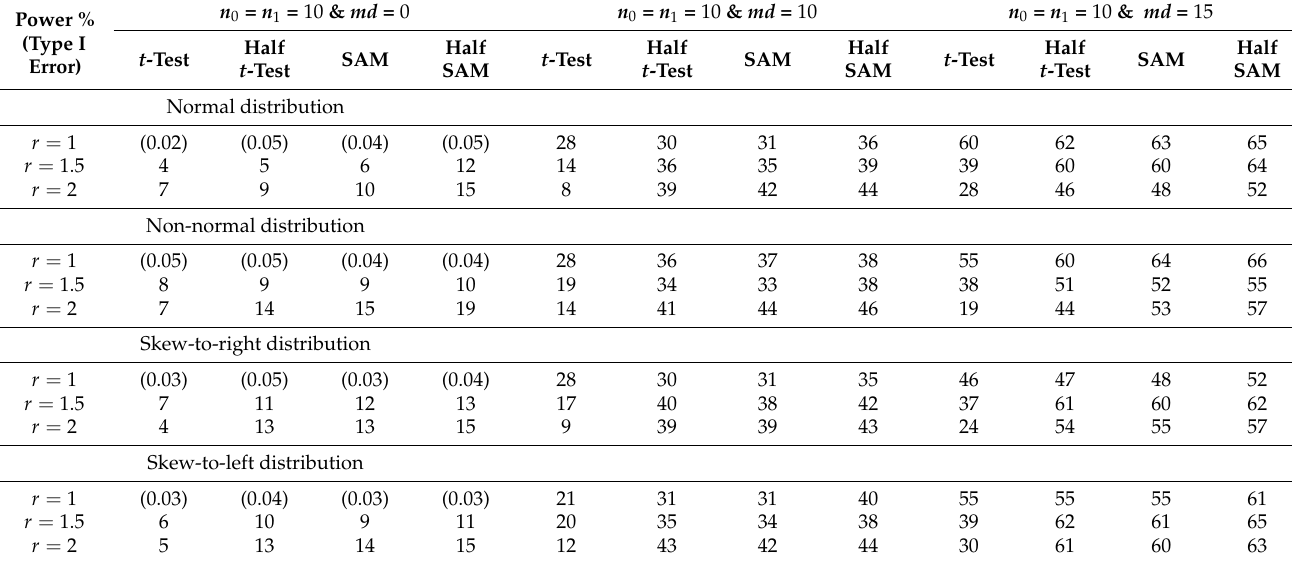
Table 1. Type I error rates and statistical power for Student’s t -test, significance analysis of microarrays (SAM), and half SAM in normal and non-normal distributions.